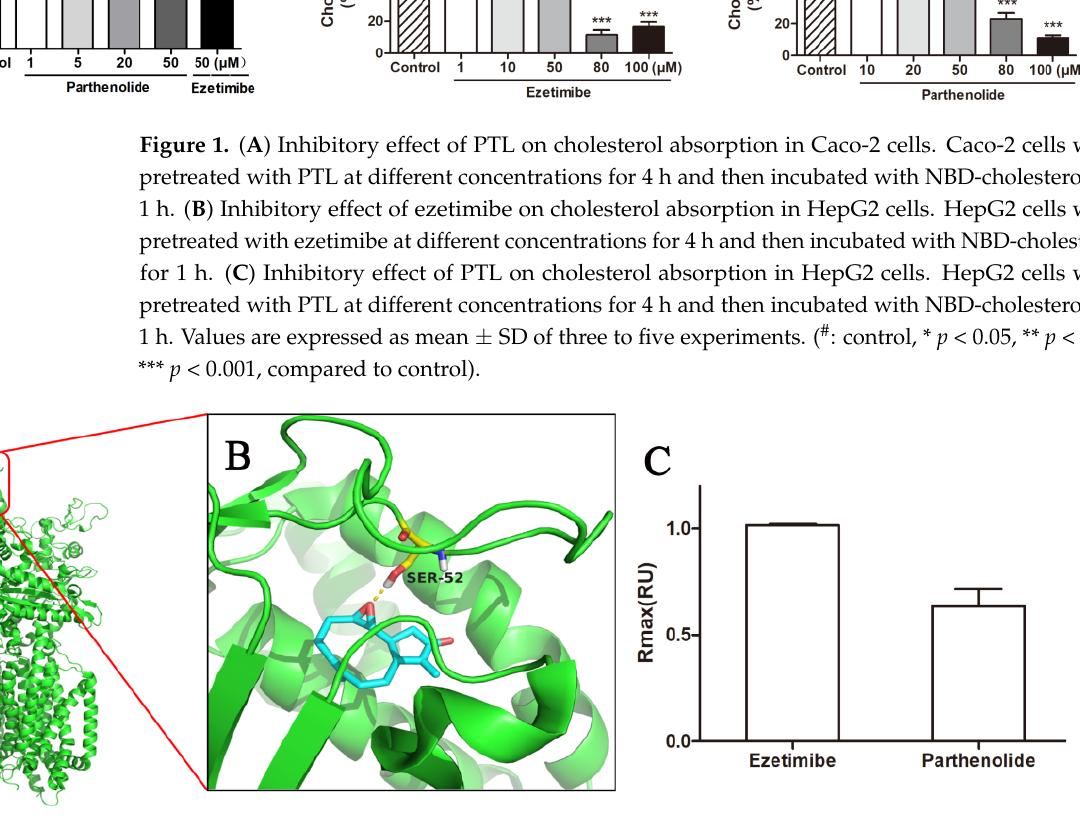
Figure 2. Binding modes of the PTL to NPC1L1. ( A ) The cholesterol ‐ binding cavity (red) in the N ‐ terminal domain. ( B ) Binding modes of the PTL to NPC1L1 (PDB: 6V3F). The PTL is shown in color by element (carbon in cyan). The H ‐ bonds are displayed using yellow dashed lines. The key amino acid residues are shown in color by element (carbon in yellow). ( C ) Interaction assay of inhibitors with NPC1L1 by SPR. Data are presented as relative maximum binding in 50 μ M. The binding of ezetimibe to NPC1L1 was normalized as 1.0.